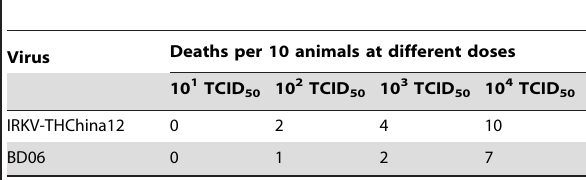
Table 2. Pathogenicity of IRKV-THChina12 and BD06 in adult mice after i.m.